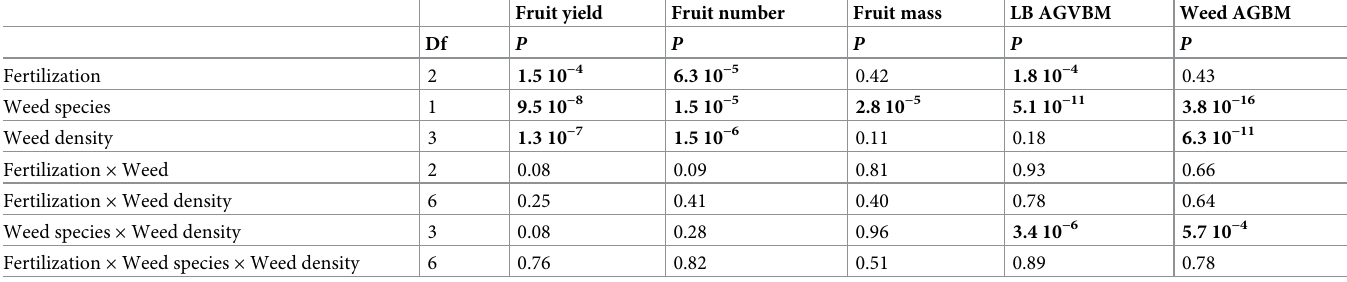
Table 1. Results of the mixed-model analyses for the tested variables of lowbush blueberry. Tested variables are fruit yield (t ha -1 ), fruit production (number of fruits ha -1 ), average individual fruit mass (mg), aboveground vegetative biomass (AGVBM, g m -2 ) and weed aboveground biomass (AGBM, g m -2 ). Fertilization treatment, weed species, and weed density were used as fixed effects, and “blocks” was used as a random effect. Significant effects are shown in bold ( P < 0.05).